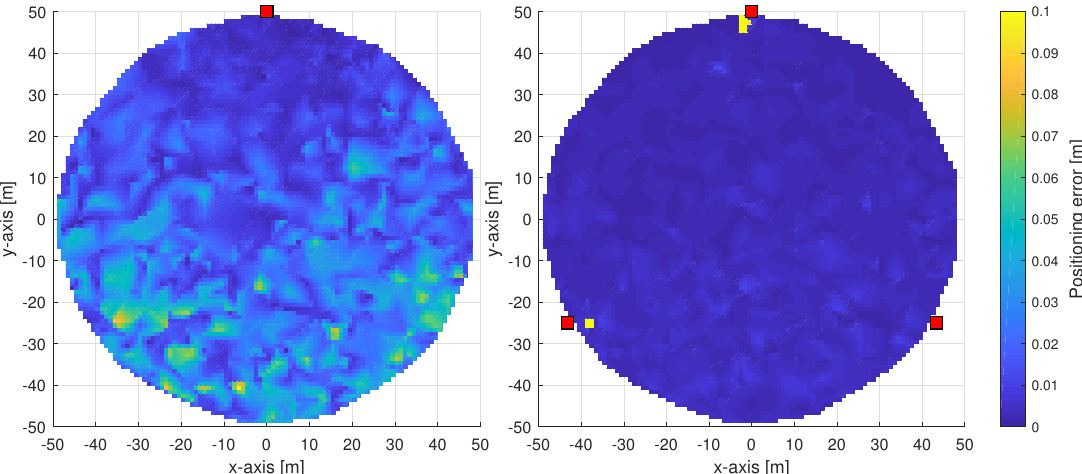
Figure 12. Urban scenarios (<50 m) mmWave NLS positioning using non-orthogonal codebook and LoS link available from one ( left side ) or three ( right side ) base